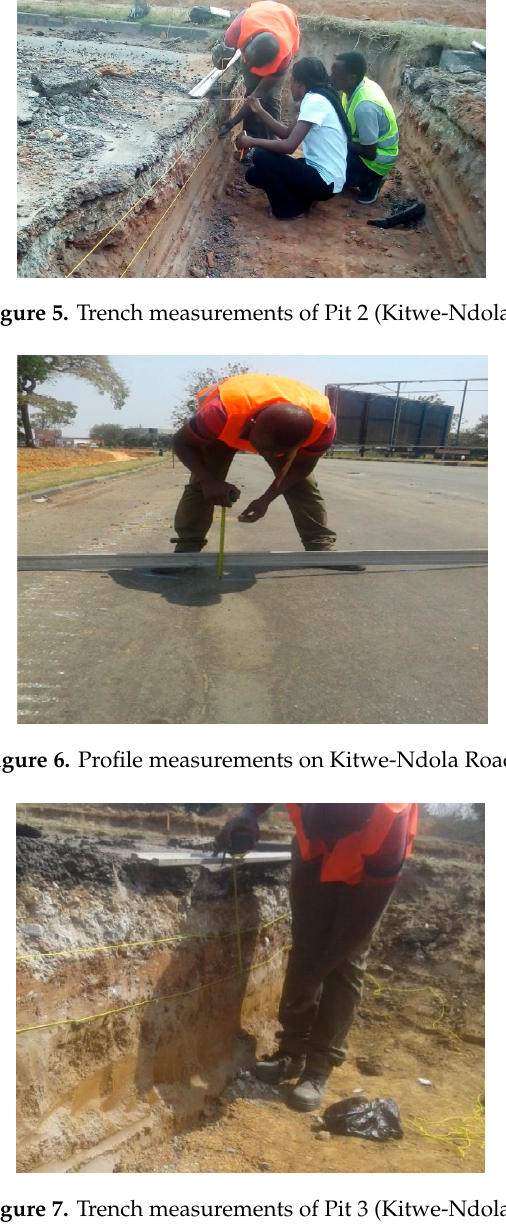
Figure 7. Trench measurements of Pit 3 (Kitwe-Ndola).